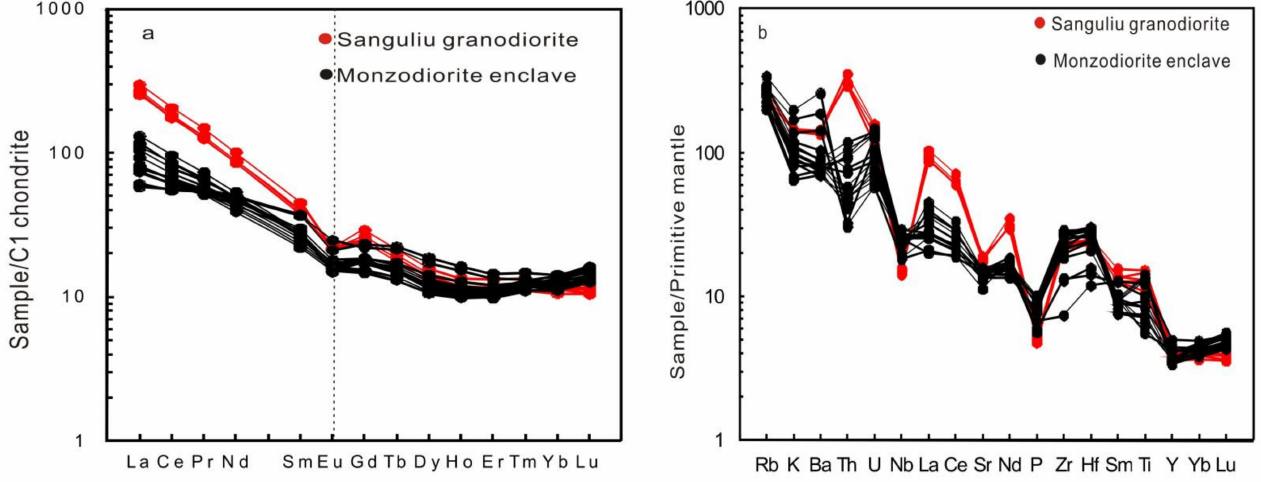
Figure 9. Chondrite-normalized REE patterns ( a ) and primitive mantle-normalized spiderdiagrams ( b ) for the Sanguliu granodiorite and monzodioritic enclaves. The chondrite and primitive mantle values are from [49].